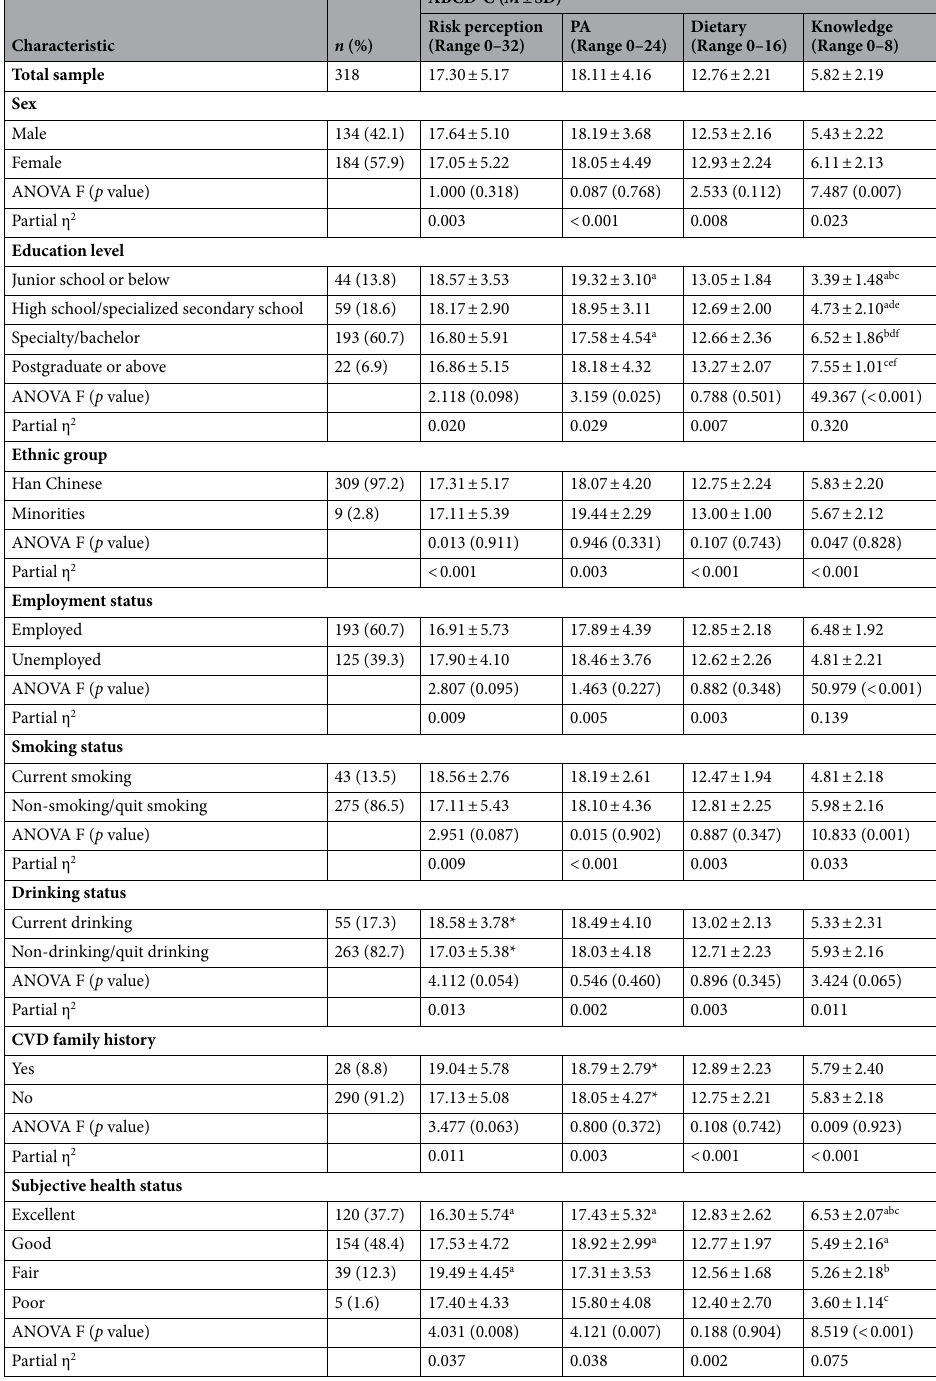
Table 1. Characteristics of the participants. ABCD-C, Chinese version of Attitudes and Beliefs about Cardiovascular Disease (ABCD) Risk Perception Questionnaire; RP, risk perception; PA, perceived benefits and intention to change physical activity; DH, perceived benefits and intention to change dietary habits; CVD, cardiovascular disease. *The significance level of the mean difference is 0.05; ** The significance level of the mean difference is 0.001. Same lower-case alphabets denote a significant difference between each level of variables in Colum, p <